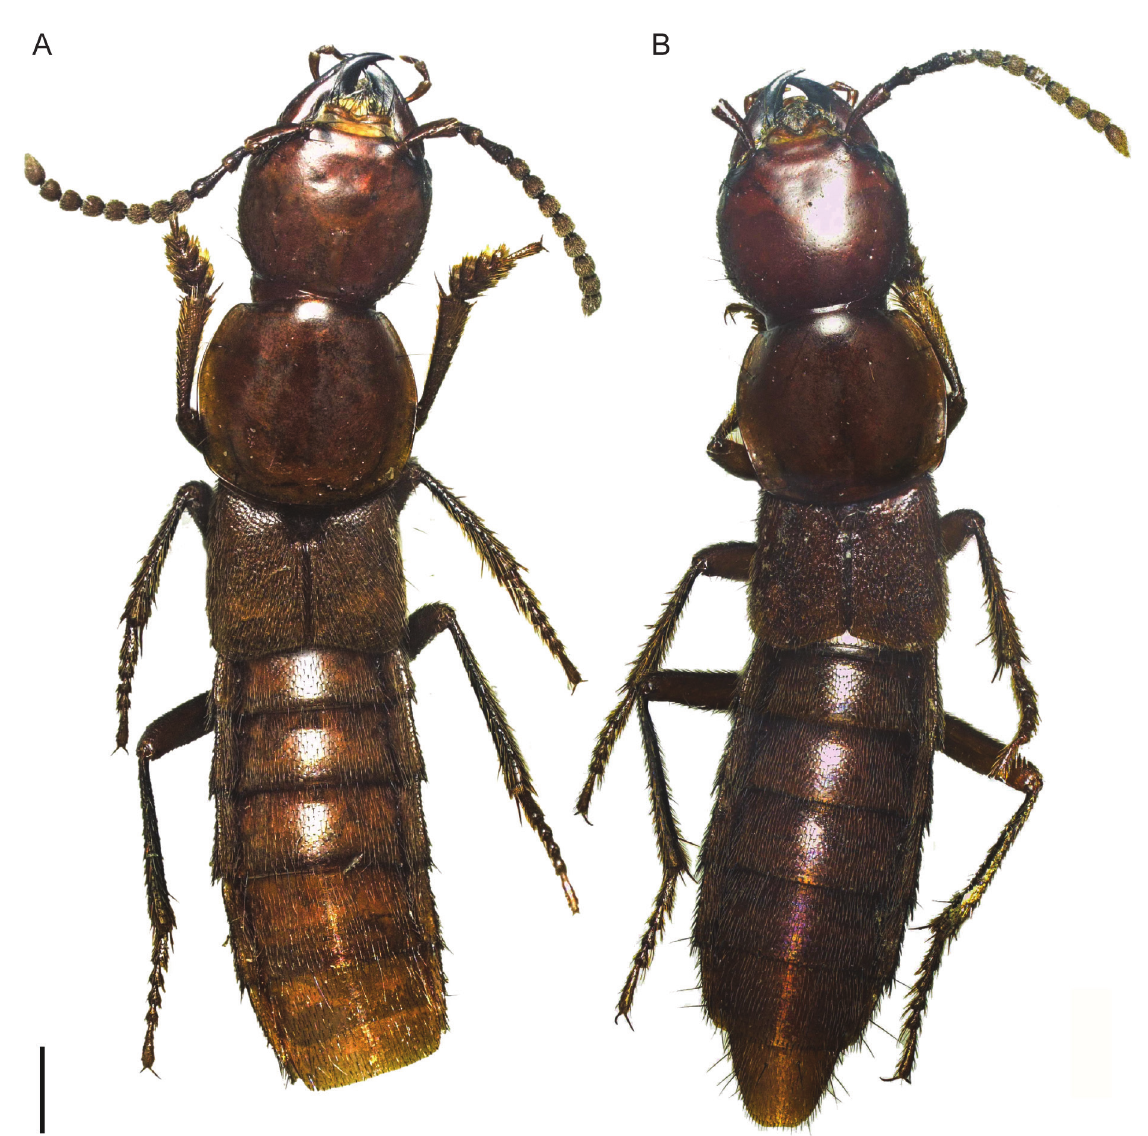
Fig. 4. Habitus images of holotypes. A . Quedius masuzoi Watanabe, 1989. B . Quedius nishikawai Watanabe, 1991. Scale bar = 1